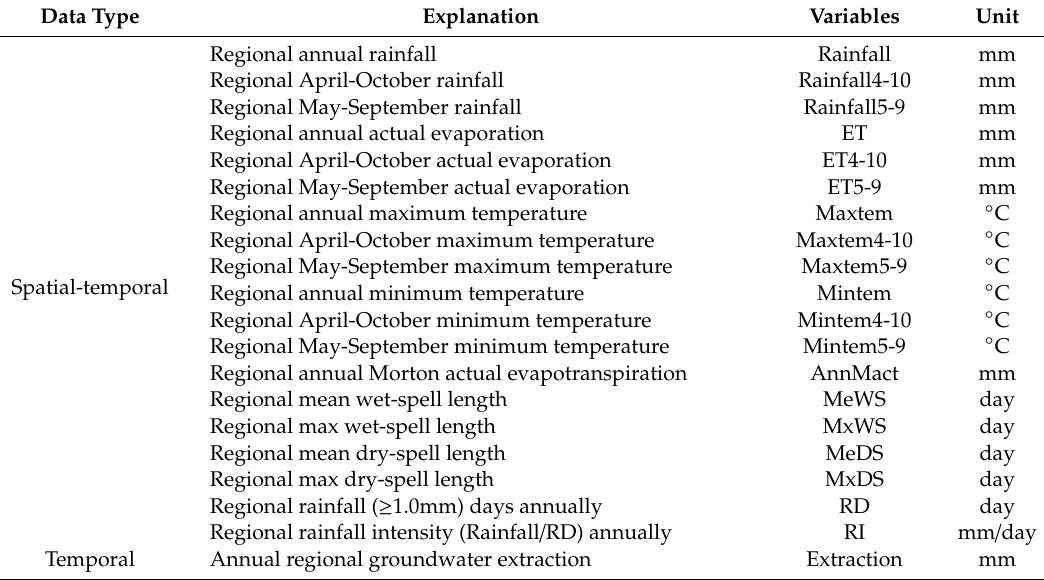
Table 1. Potential variables used in this